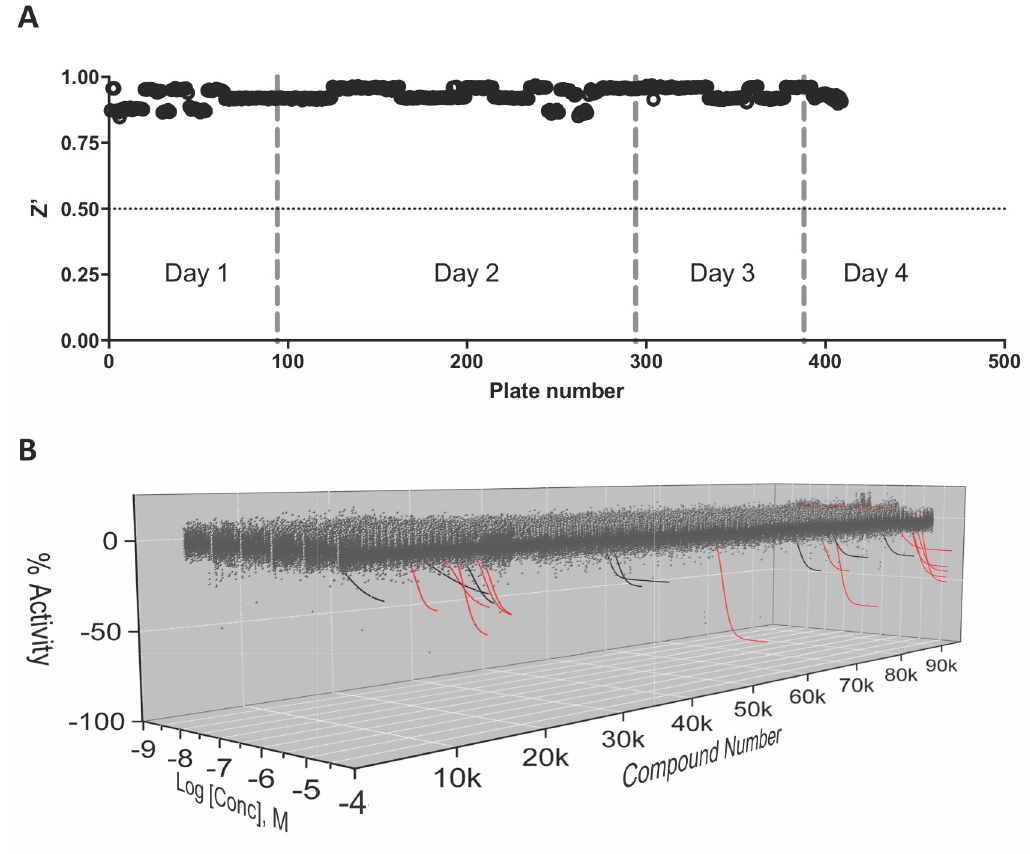
Fig 14. qHTS screen of the NCATS Genesis library (94,965 compounds) using the LANCE TR-FRET assay. (A) Z’ factor calculated from the intraplate controls. (B) Normalized activity of all compounds tested in a 6-point concentration response. Rendered curves represent all compounds displaying an activity with negative curve class. The curves rendered in red have a maximum activity � -25%.